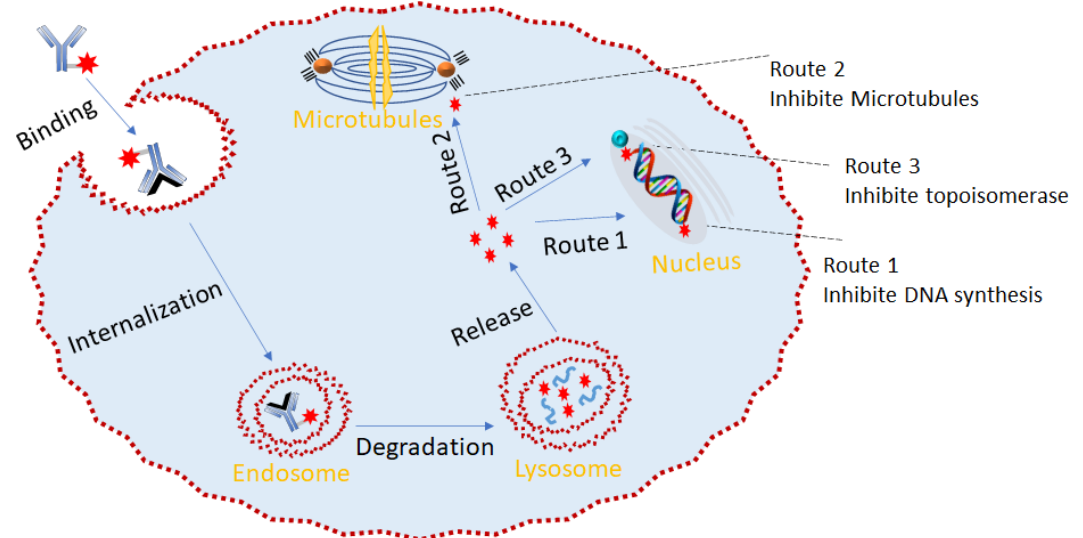
Figure 22. Mechanism of action of ADCs: ADC binds to a cell-surface antigen that is ideally specific to a cancer cell. Upon binding, the ADC-antigen is internalized into the tumor cell. When the complex is degraded, it releases the cytotoxin, which then binds to its target to cause cancer cell apoptosis.